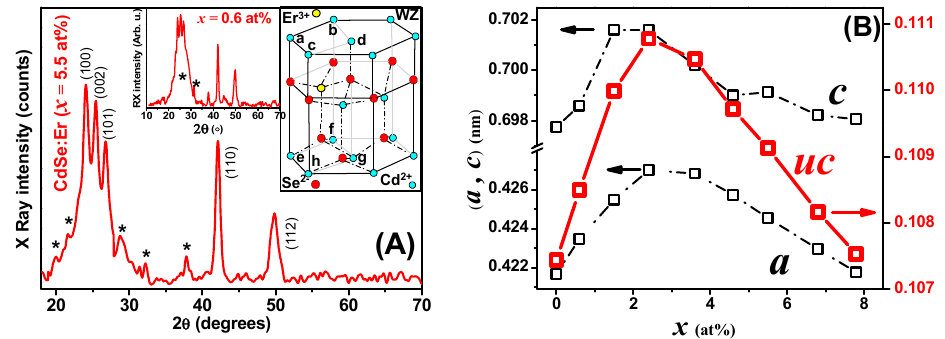
Figure 1. ( a ) EDS as a function of V R . Dashed line represents a linear fitting. (i) and (ii) insets illustrate images of the V R = 15% doped and undoped Cd 1- x Er x S samples, respectively. ( b ) TEM image of sample for x = 4.6 at%, where the (002) planes of wurtzite phase of CdSe are represented. The inset shows a SAED pattern of the WZ crystalline structure.